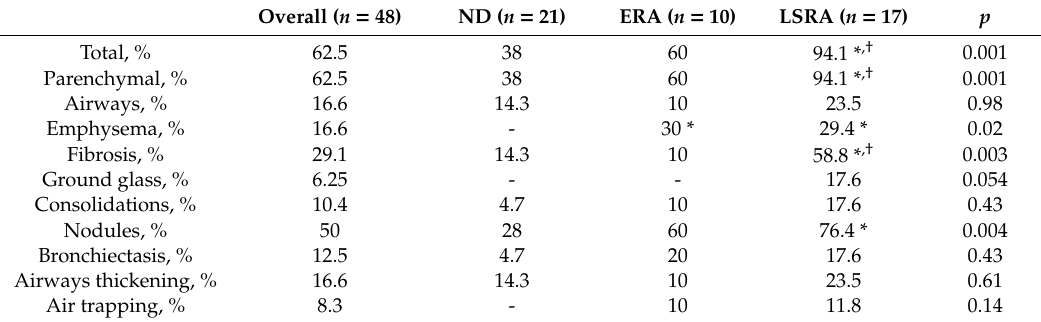
Table 3. Frequencies of total and selected lung abnormalities at high-resolution computed tomography (HRCT)